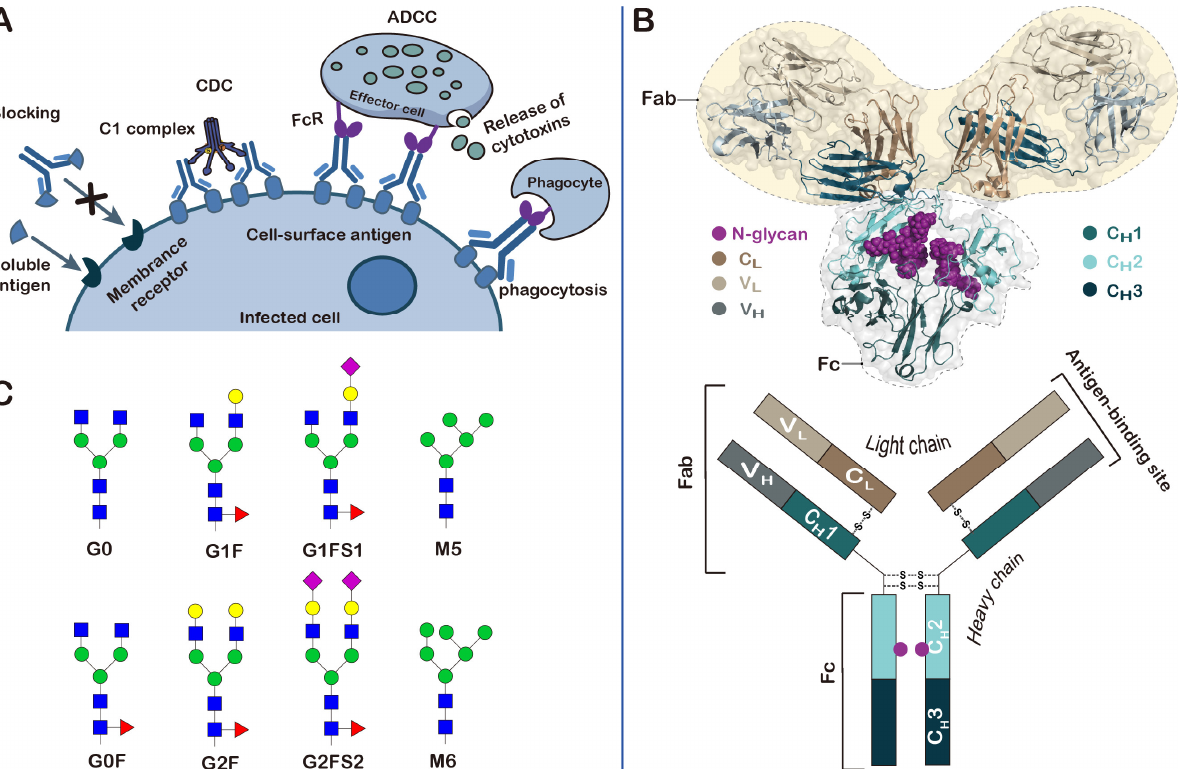
Figure 3. Structure, function and glycosylation of antibodies. ( A ) Schematic representation of the biological functions of antibodies ; ( B ) a representative three-dimensional structure of IgG (PDB ID: biological functions of antibodies; ( B ) a representative three-dimensional structure of IgG (PDB ID: 1IGY); ( C ) the N-glycan structures found on the IgG antibodies. 1IGY); ( C ) the N-glycan structures found on the IgG